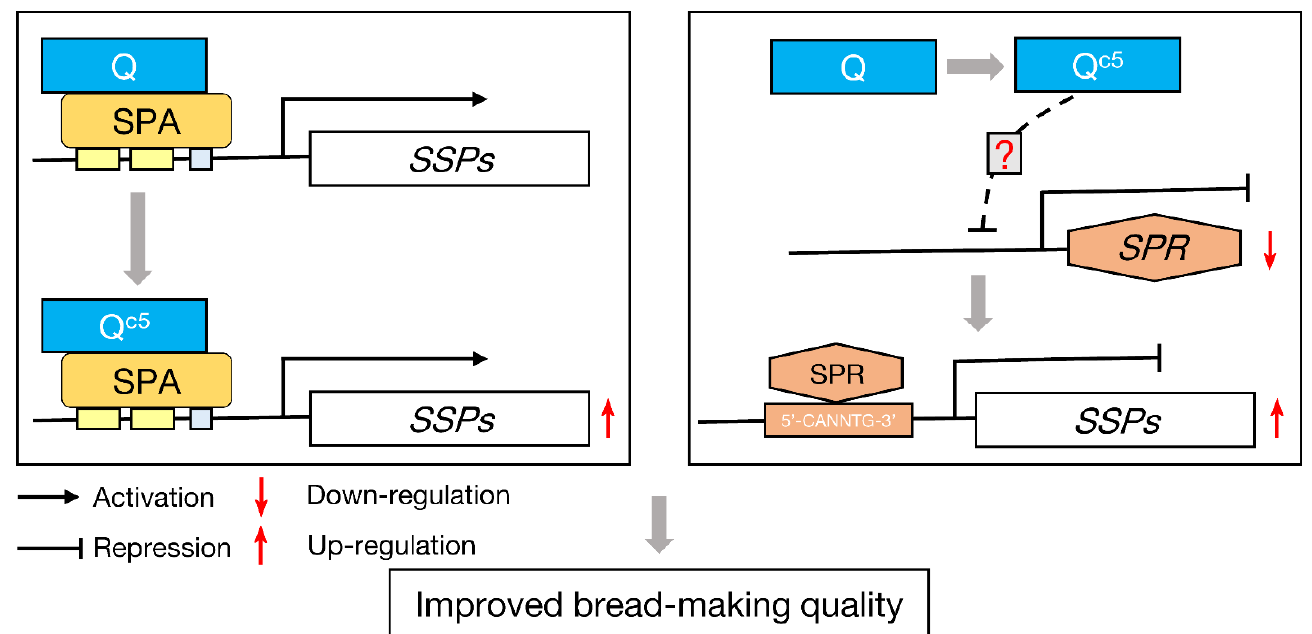
Figure 6. Schematic diagram of the regulatory effect of Q c5 on SSP gene expression in wheat seeds. The activation of SSP expression by SPA is inhibited by Q, but the missense mutation from Q to Q c5 weakens this inhibition, resulting in more SSP accumulation. Moreover, the missense mutation in Q c5 down-regulates SPR expression; since SPR functions as a repressor of SSP genes, the suppression of SPR results in up-regulated SSP expression levels. Taken together, the up-regulated SSPs expression results in improved bread-making quality. Solid and dotted arrows indicate direct and indirect regulation, respectively. The question mark indicates the regulatory effect of Q on SPR expression remains to be elucidated.